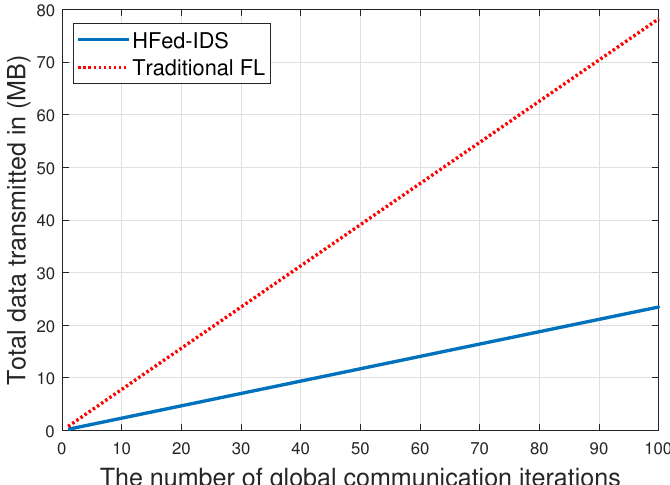
Figure 6. The size of transmitted data in the core network at each